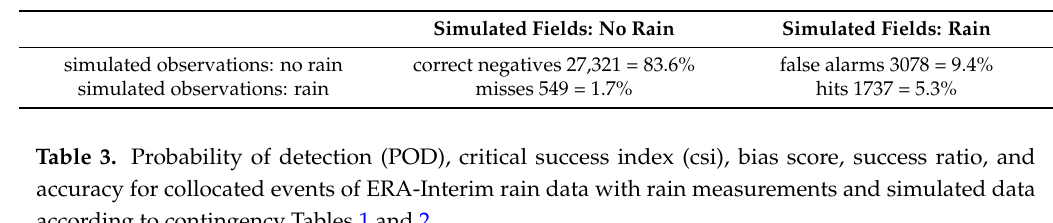
Table 2. Contingency table for binary statistics collocated events of simulated fields and simulated rain observations based on weather radar data. The total number of collocated events is 32,685.The numbers of the proportions to the total number are also given.